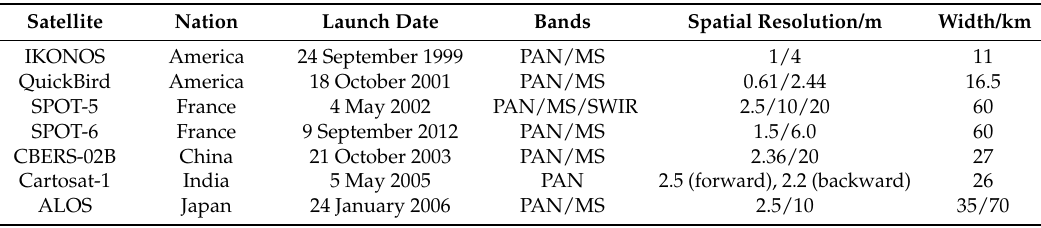
Table 1. High-resolution optical satellite system. PAN: panchromatic, MS: multispectral, SWIR: Shortwave